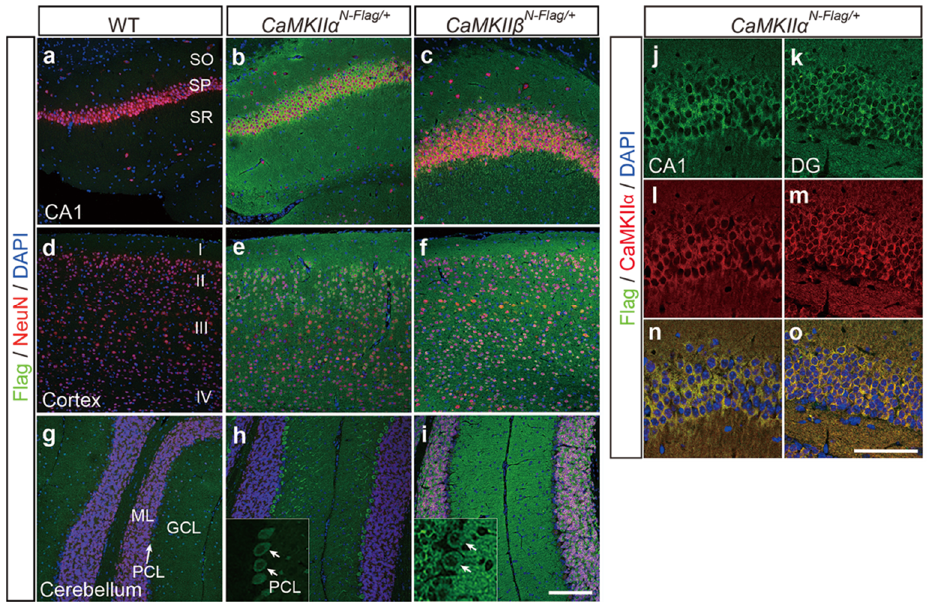
Figure 4. Detection of Flag-CaMKIIα and Flag-CaMKIIβ by immunohistochemistry. Immunostaining of hippocampal CA1 region ( a – c ), cortex ( d – f ), and cerebellum ( g – i ) of wild-type (WT, ( a , d , g )), CaMKIIα N-Flag ( b , e , h ), and CaMKIIβ N-Flag ( c , f , i ) using anti-Flag (green) and neural marker anti-NeuN (red) antibodies. DAPI (blue) is nuclear marker. SO, stratum oriens, SP, stratum pyramidal, SR, stratum radiatum, SLM, stratum lacunosum-moleculare. Cortical layer I, II, III, and IV in D. ML, molecular layer, PCL, Purkinje cell layer, and GCL, granule cell layer. ( j – o ) Staining of anti-CaMKIIα and anti-Flag/DYKDDDDK antibodies showed complete overlap in cytoplasmic region of hippocampal CA1 ( j , l , n ) and dentate gyrus (DG) ( k , m , o ) of CaMKIIα N-Flag/+ mice. Scale bar = 100 μm in ( a – i ), 50 μm in ( j – o ).